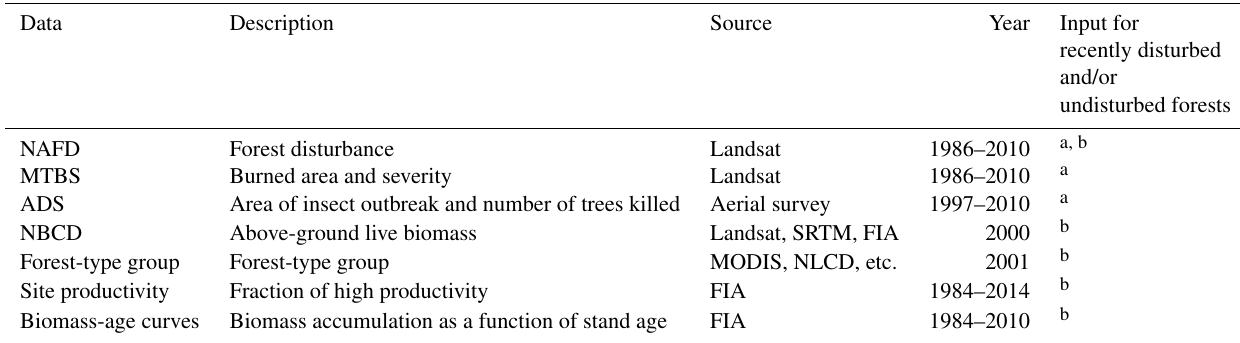
Table 1. Data sources for inferring time since disturbance for recently disturbed and undisturbed forest pixels.